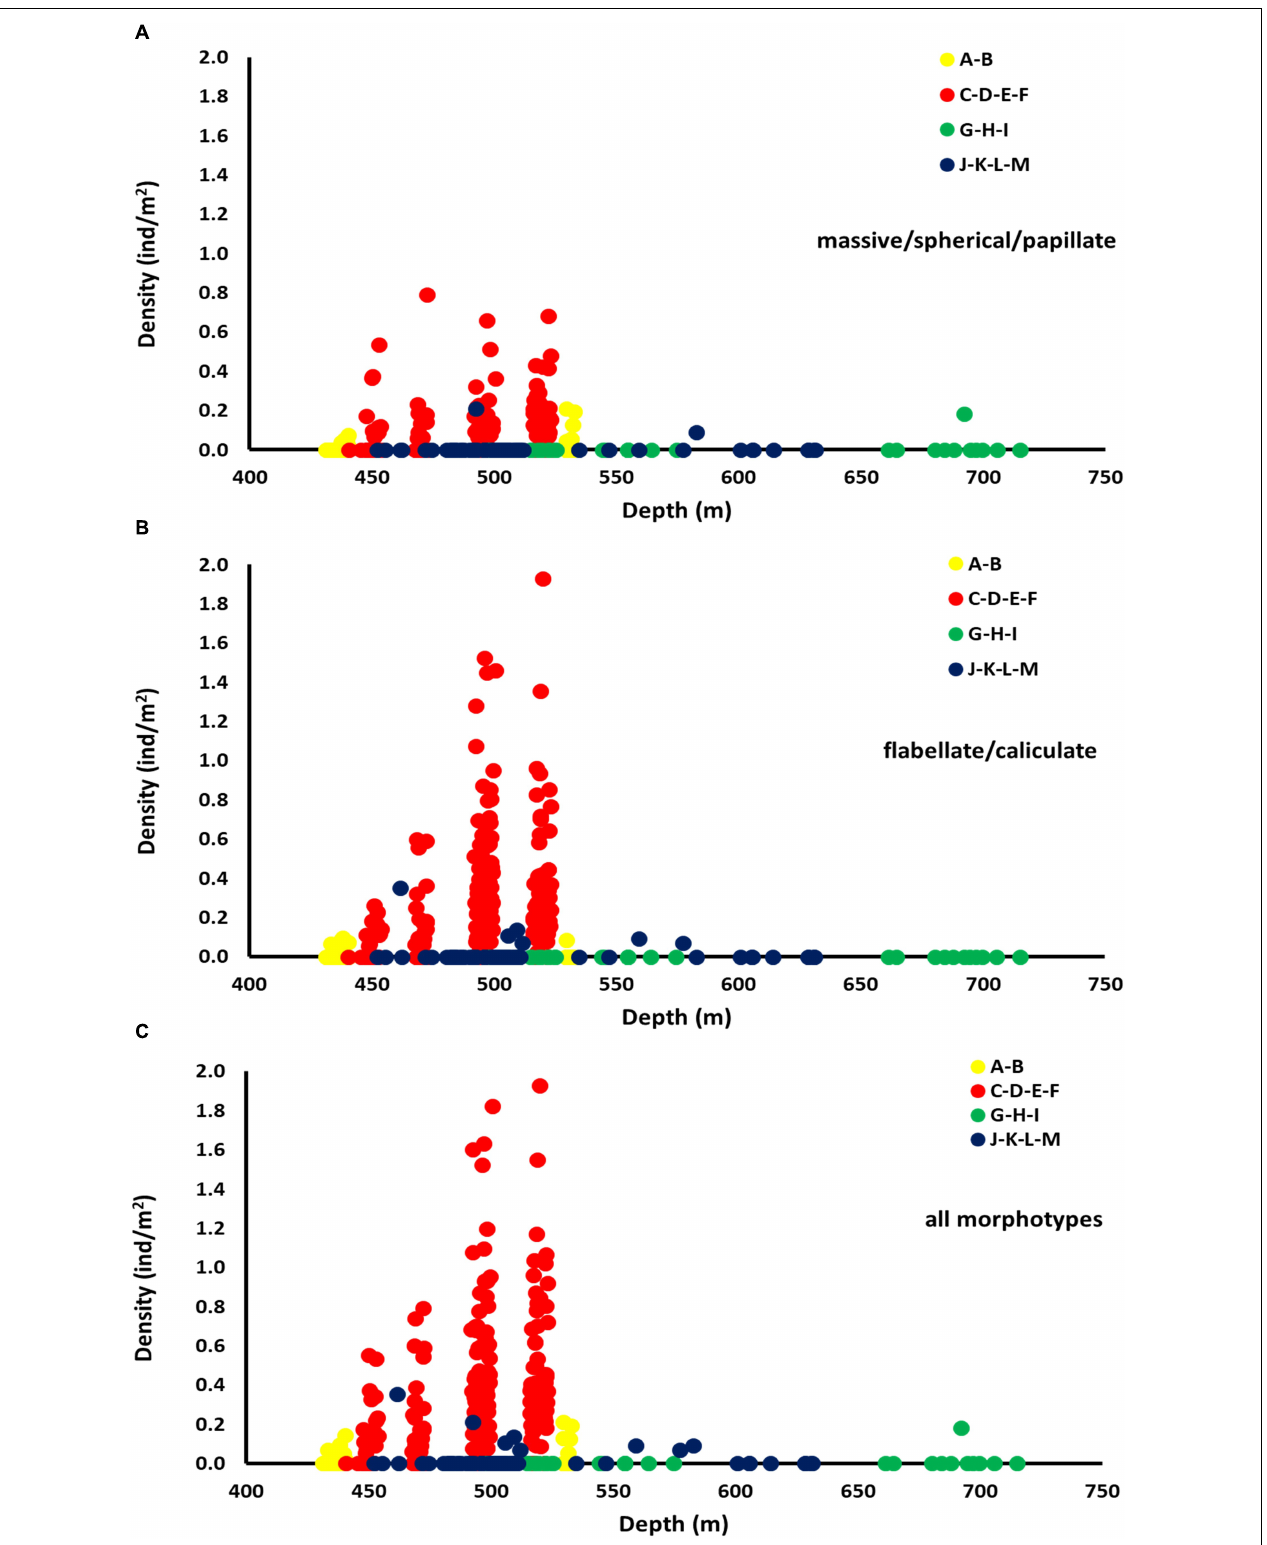
FIGURE 8 | Density (individuals/m 2 ) of sponge morphotypes across depth in each of the four areas: Area 1 (transects A-B), Area 2 (transects C-D-E-F), Area 3 (transects G-H-I), Area 4 (transects J-K-L-M). Data shown for Category 3 (massive/spherical/papillate) (A) , Category 4 (flabellate/caliculate) (B), and for all sponge morphotypes (C)